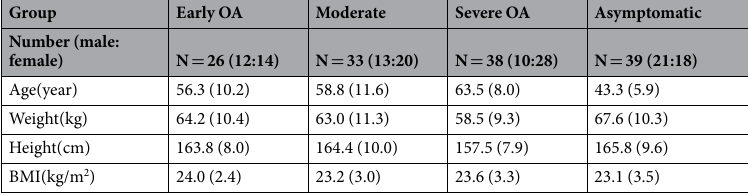
Table 1. Mean ( ± SD) of demographic and anthropometric characteristics of the